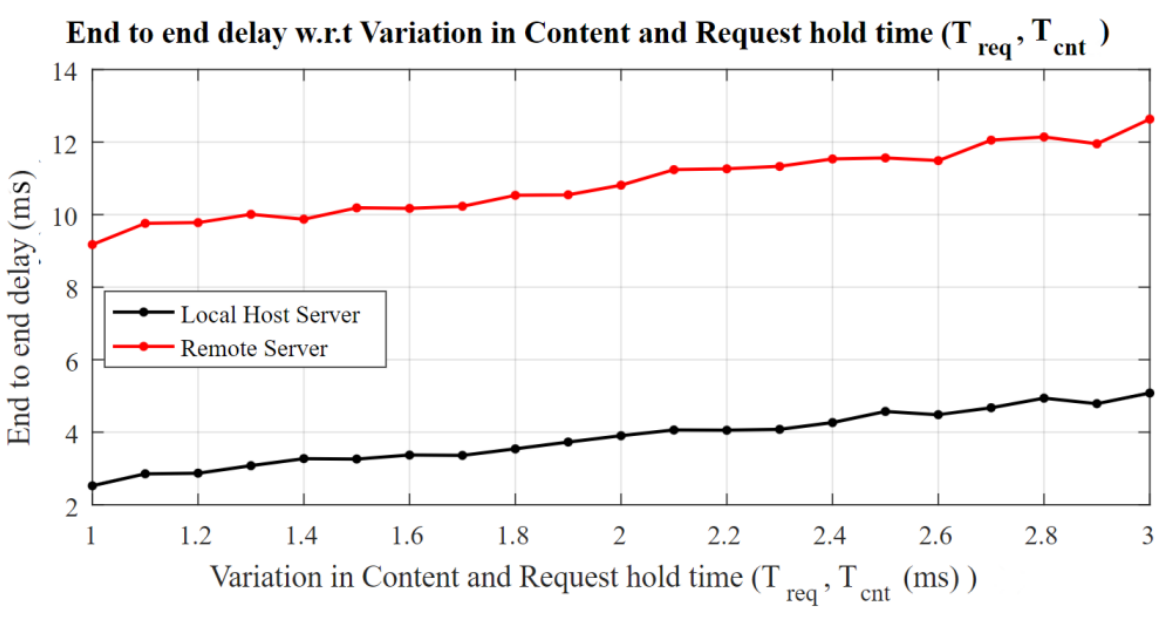
Figure 7. End-to-end delay w.r.t variation in content request time and content holding time.